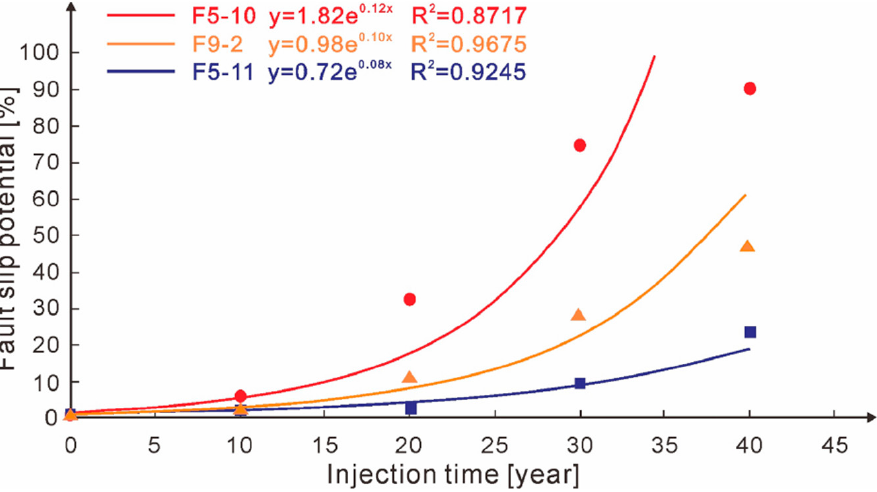
Figure 10. Fault slip potential variations with time for fault segments F5-10, F5-11, and F9-2.